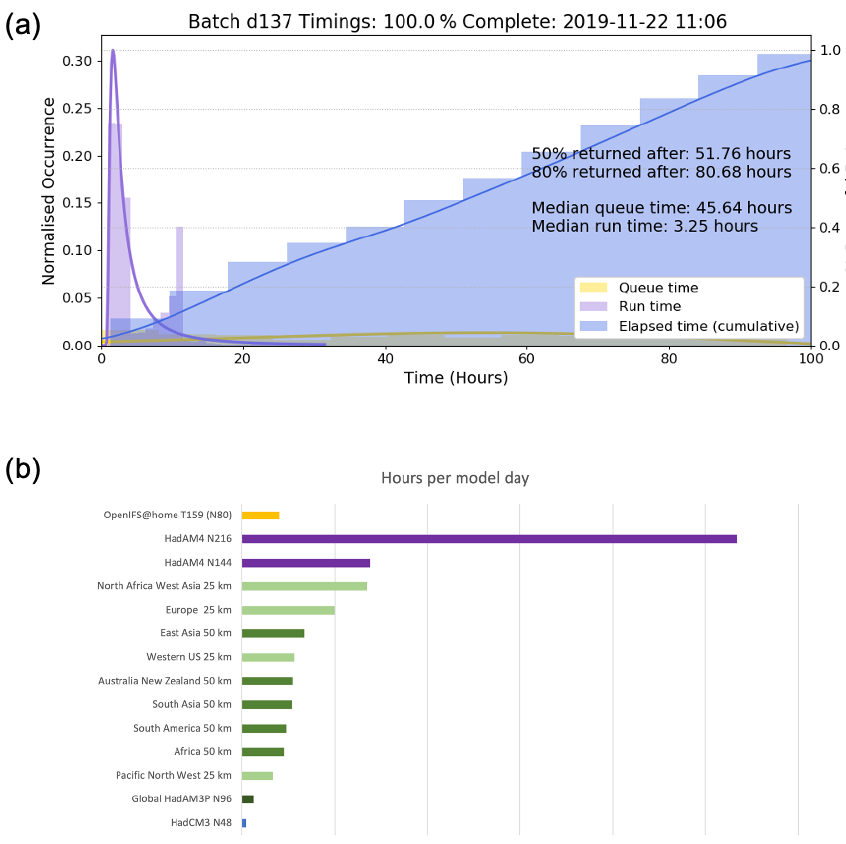
Figure 2. (a) The relevant timings associated with the validation batch. The queue time (yellow) and run time (purple) distributions are straight occurrence distributions, whereas the elapsed time (blue) is a cumulative distribution expressed as a percentage of the successful returns. (b) Run time information in hours per model day based on a representative batch for applications on the CPDN platform (note these numbers are indicative rather than definitive). ECMWF OpenIFS@home is depicted in yellow, UK Met Office weather@home (HadAM3P with various HadRM3P regions) configurations are depicted in green (with light green indicating a 25km embedded region, green indicating a 50km embedded region, and dark green indicating where only the global driving model is computed). The UK Met Office low-resolution coupled atmosphere–ocean model HadCM3 is shown in blue, and the high-resolution global atmosphere HadAM4 at N144 ( ∼ 90km mid- latitudes) and N216 ( ∼ 60km mid-latitudes) are shown in purple.